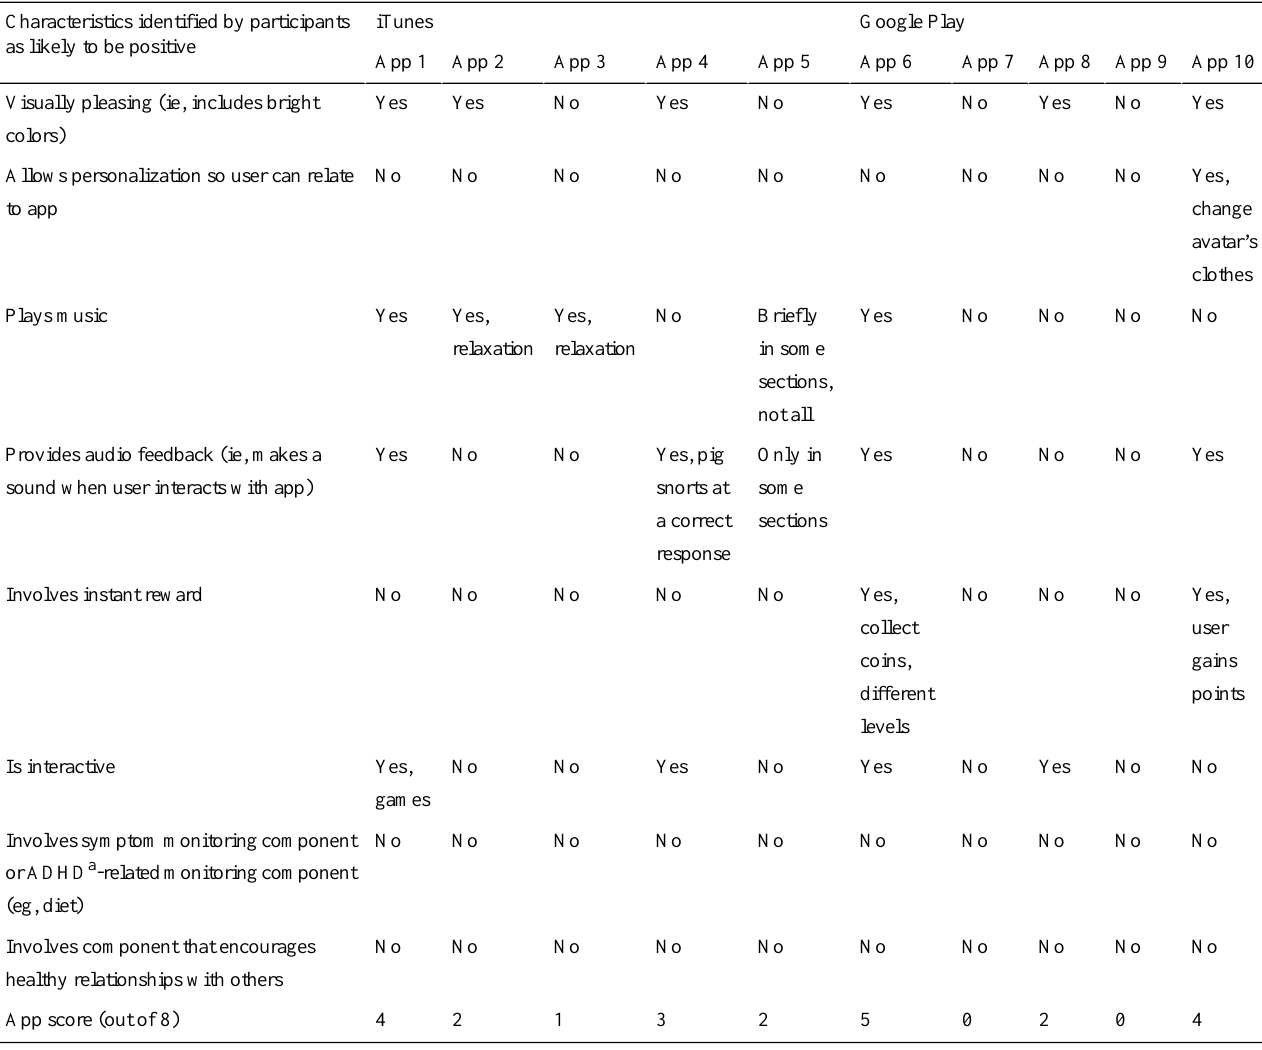
Table 3. Summary of what makes an app suitable for a child or young person with attention-deficit/hyperactivity disorder (ADHD; left column), according to the children and young people with ADHD and the clinicians interviewed in this study and which apps identified in this study include these characteristics. Authors have examined each app against the criteria identified by participants and scored the apps out of 8 to highlight how they, mostly, are not in line with the needs of their target audience.